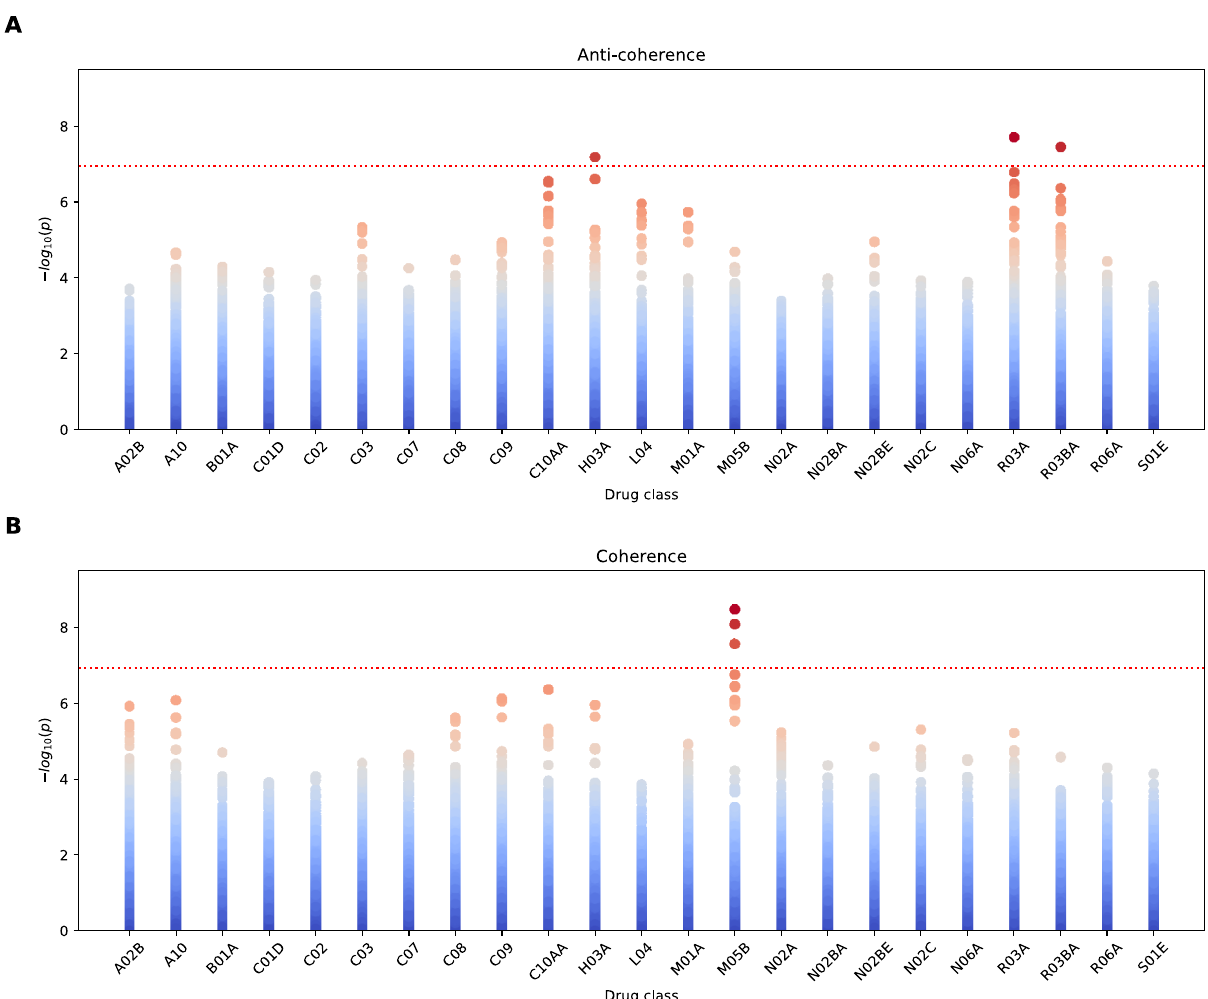
Fig 4. Resulting p -values for cross-scoring 23 drug classes GWAS against very severe COVID-19 GWAS for anti-coherence (A) and coherence (B). Each data point corresponds to a gene. The dotted red line marks a Bonferroni significance threshold of 1.18 × 10 − 7 (0.05 divided by the 18453 genes tested and 23 drug classes). Note that the drug class M05B shows the most significant enrichment in coherence with severe